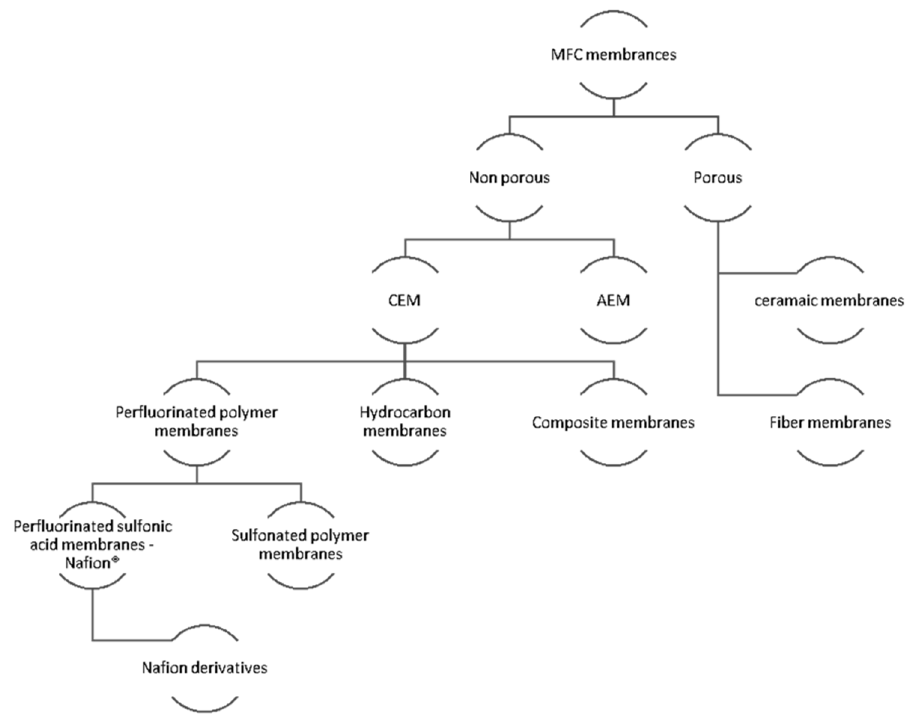
Figure 6. Classification of actively used MFC